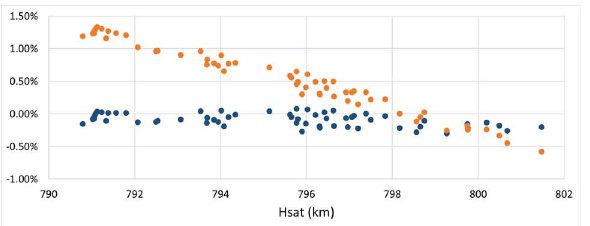
Figure 19 : Time delay errors vs satellite altitude for D06 detector (~nadir). Dark blue: proposed L1C estimation. Orange: ESA handbook table. Satellite altitude dependency is well